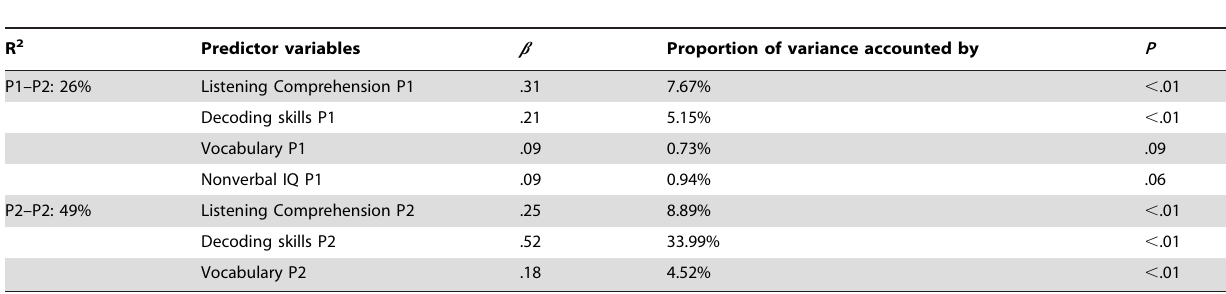
Table 4. Standard multiple regression analyses with the reading comprehension of utterances as dependent variable and variables of interest at P1 and P2 as predictors (for decoding skills: fluency in pseudoword reading).